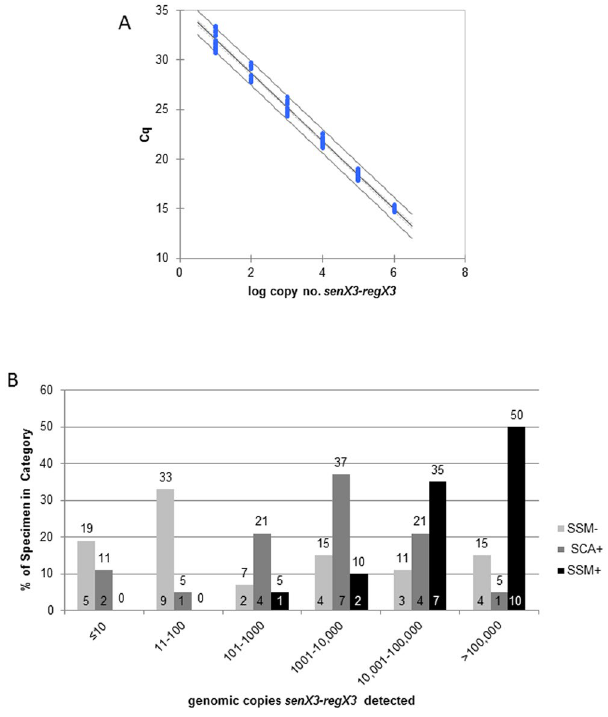
Figure 4. Distribution of genomic copies extracted from smear positive, scanty smear positive and smear negative samples. ( A ) Standard curve of senX3-regX3 log copy number 10 6 –10 copies of 7 extractions combined (118 data points). Y = − 3.42X + 35.47. (95% CI of slope: − 3.35, − 3.48) R 2 = 0.989. ( B ) Percentage of samples in different copy number distribution. SSM − = sputum smear microscopy negative (N = 27); SCA = scanty sputum smear positive (N = 19); SSM + = sputum smear microscopy positive (N = 20). Numbers at top of bars indicate percentage of positive specimen in each category. Numbers at bottom of bar indicate number of positive specimen in each